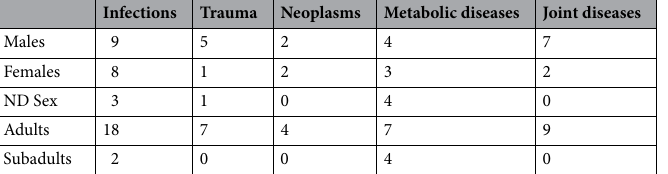
Table 7. Frequency of pathologies identified on individual from the excavaed mass-graves at the Lazaretto dell’Osservanza (ND: not